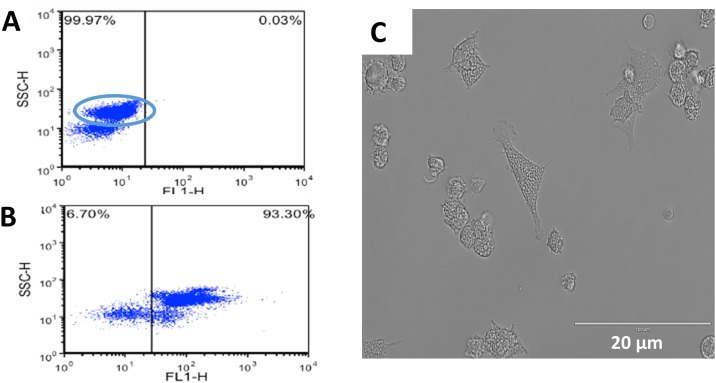
In vitro generation of canine monocyte-derived macrophages.Monocytes were obtained by positive selection using CD14 monoclonal antibody coated columns. CD14+ monocytes were then seed in 12 or 24 wells plates at 1x106 cell/mL in DMEM enriched with 50 ng/mL of canine GM-CSF. Macrophages were allowed to mature for 7 days upon which were used for the experiments. Flow cytometry after monocyte isolation: (A) Control and (B) CD14+ cells. (C) Morphology of adherent macrophages after 7 days of incubation with DMEM and GM-CSF by light microscopy. Scale bar = 20 μm. Similar data were obtained in three independent experiments using macrophages from different animals.